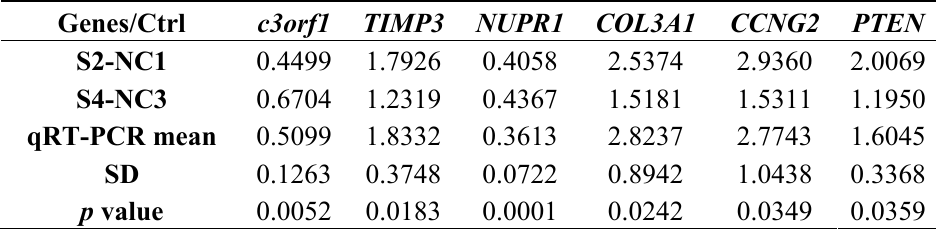
Table 3. Relative mRNA expression of target genes in C3orf1-depleted 95D cells compared to control